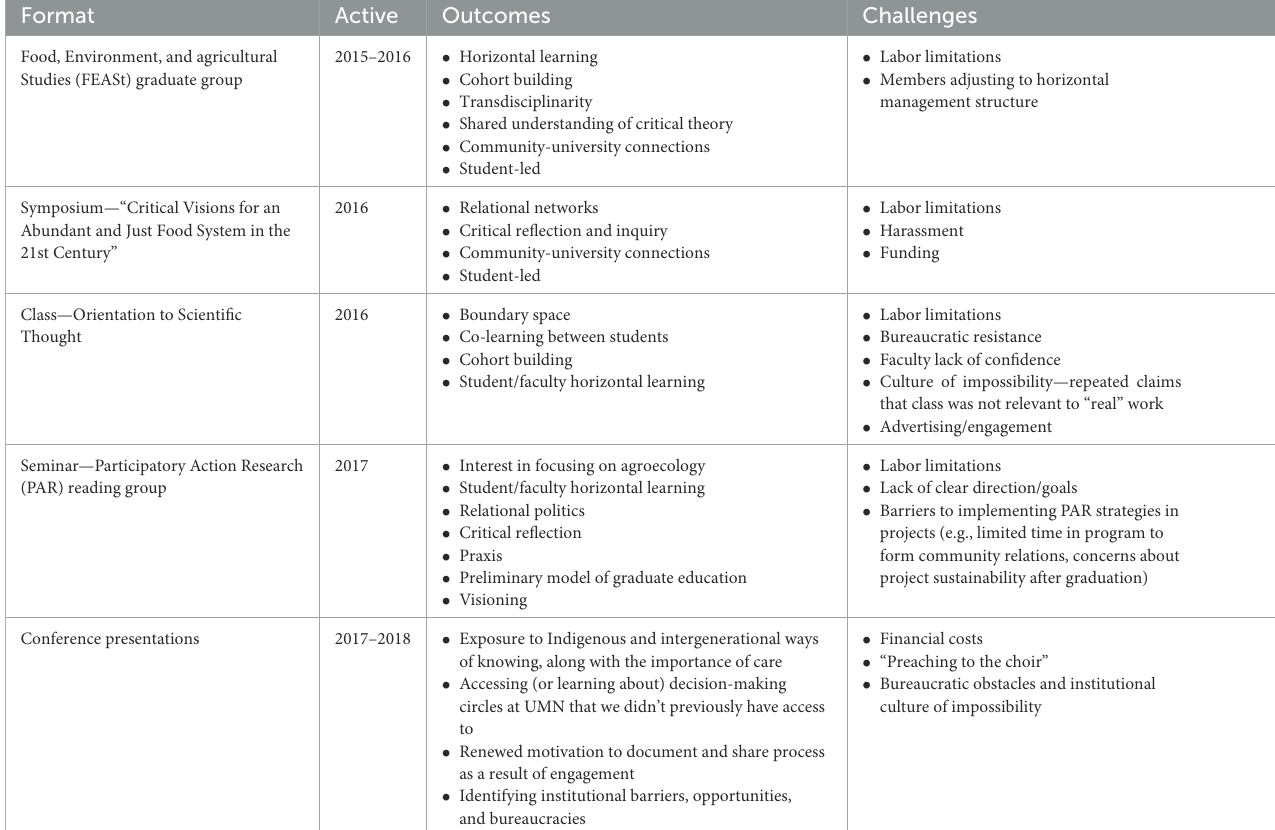
TABLE 1 Summary of student-led organizing that informed workshop series and pedagogy model